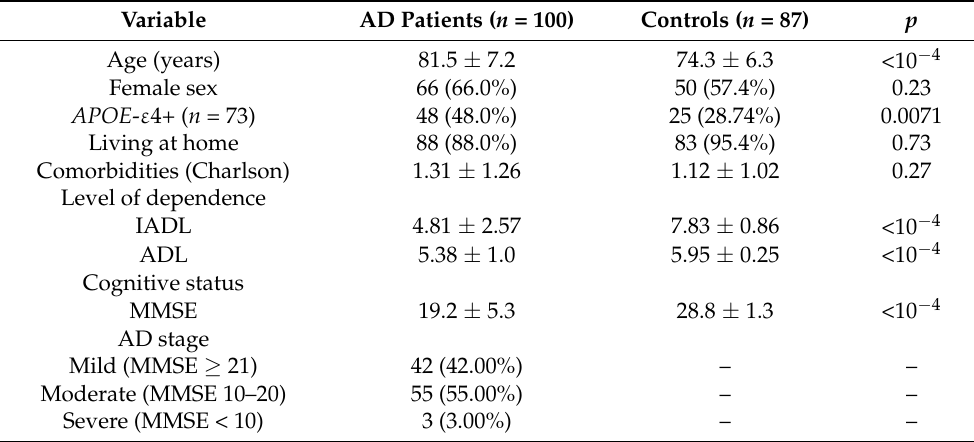
Table 1. Demographic and clinical characteristics of the study